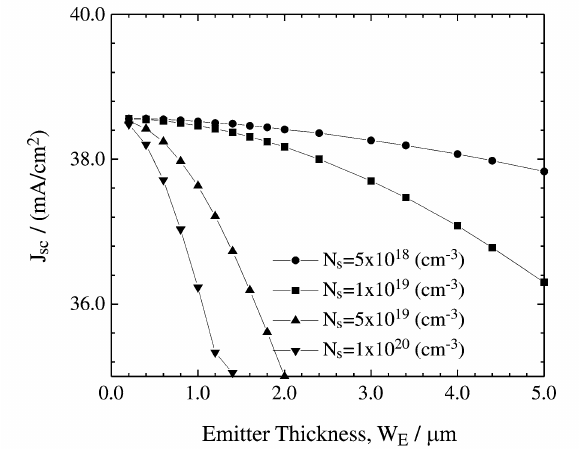
Figure 3. Solar cell short-circuit density (J sc ) as a function of emitter thickness (W E ), considering different doping levels (metal grid shadowing factor F m =